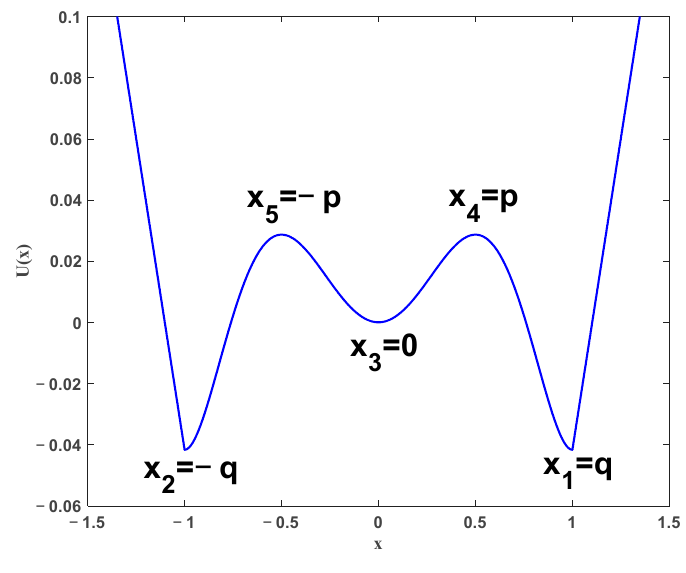
Figure 1. Potential function ( 𝑚 = 1, 𝑝 = 0.5, 𝑞 = 1 ).